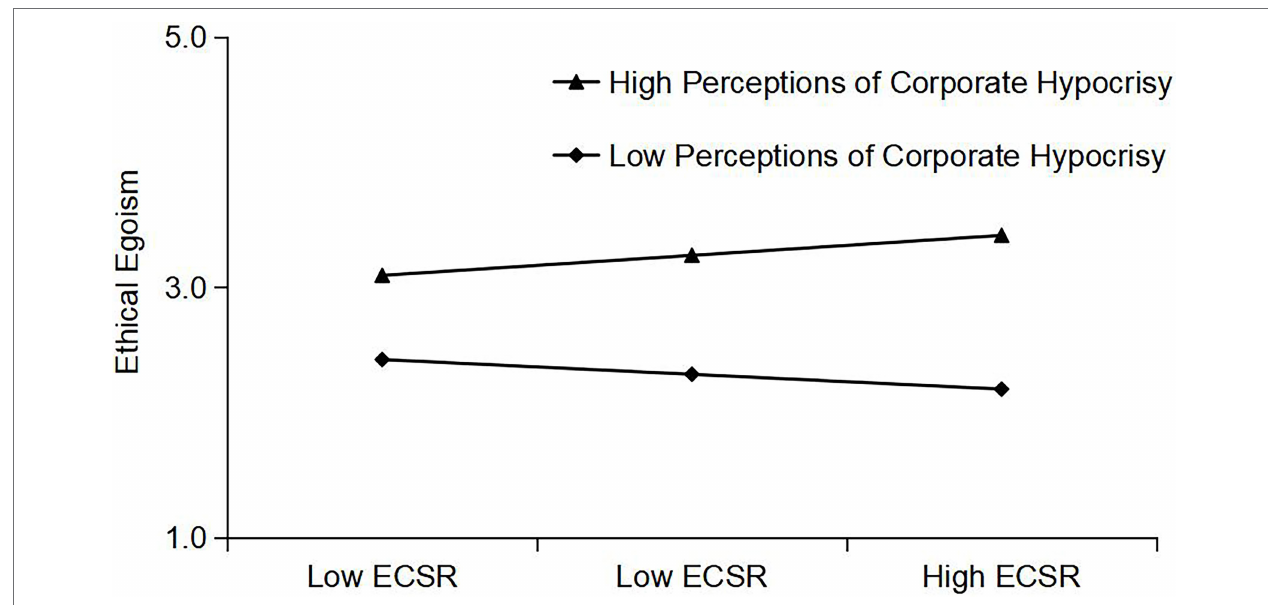
FIGURE 2 | External CSR and ethical egoism: moderating effect of perceptions of corporate hypocrisy.